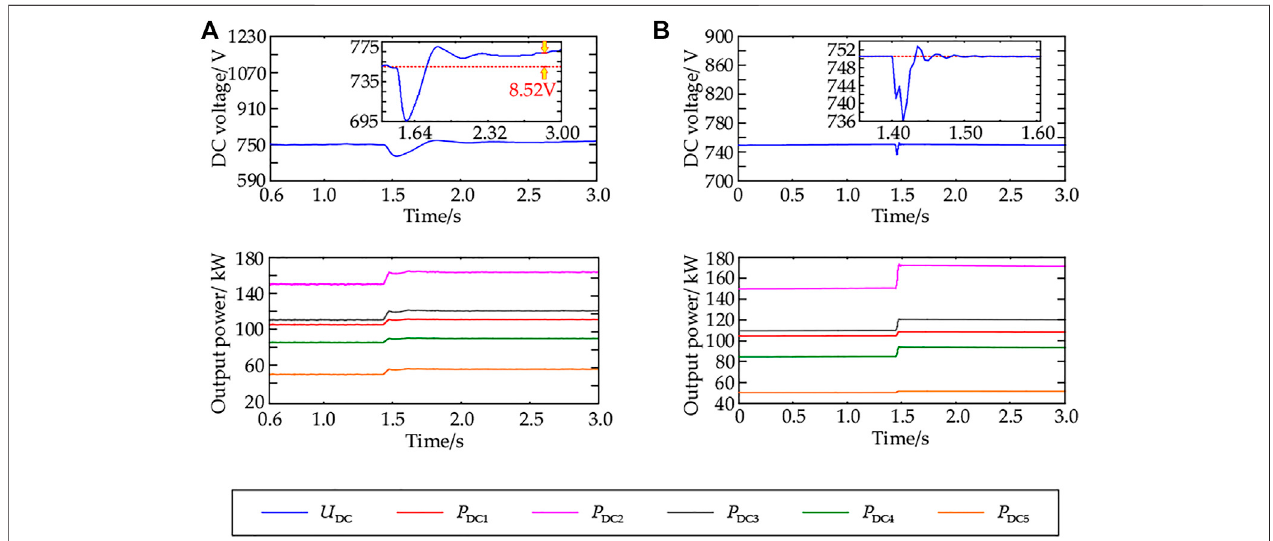
FIGURE 8 | Simulation waveforms of equivalent load fl uctuation in the DC network: (A) simulation waves based on traditional droop control; (B) simulation waves based on adaptive droop control.